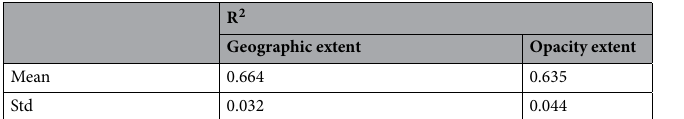
2 Table 2. Summary of R between predicted scores from the COVID-Net S deep neural networks and the radiologist scores for the 100 experiments (50 deep neural networks for geographic extent scoring and 50 deep neural networks for opacity extent scoring).